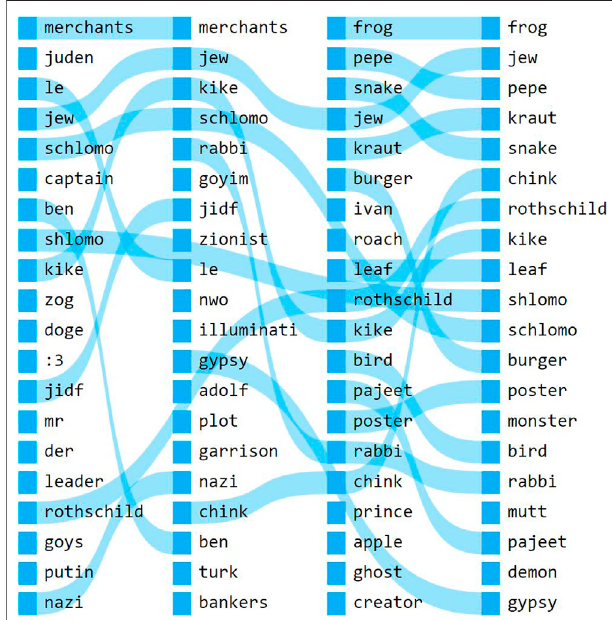
FIGURE2| Rank fl owdiagramofwordssimilarto merchant inour4chan dataset. Similar words are sorted vertically, from most similar to least similar. Each vertical stack represents a single snapshot, respectively 2012-2014, 2014-2016, 2016-2018, and